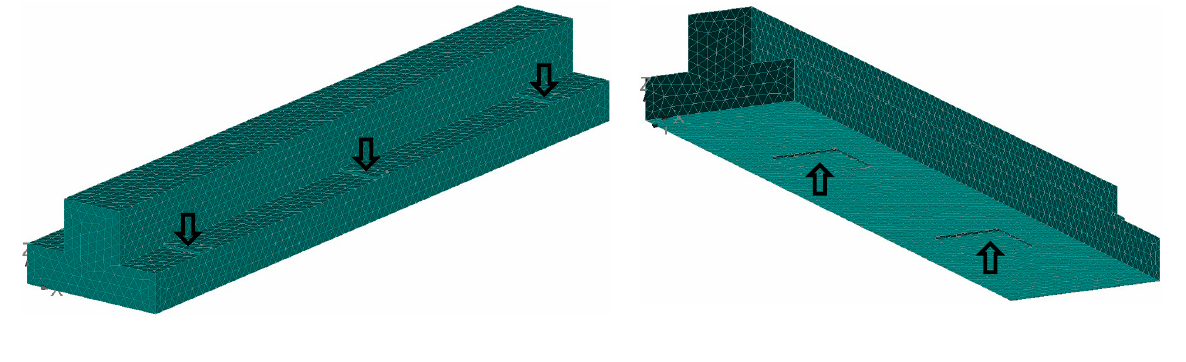
Figure 5. Bilinear stress–strain response of steel bars.